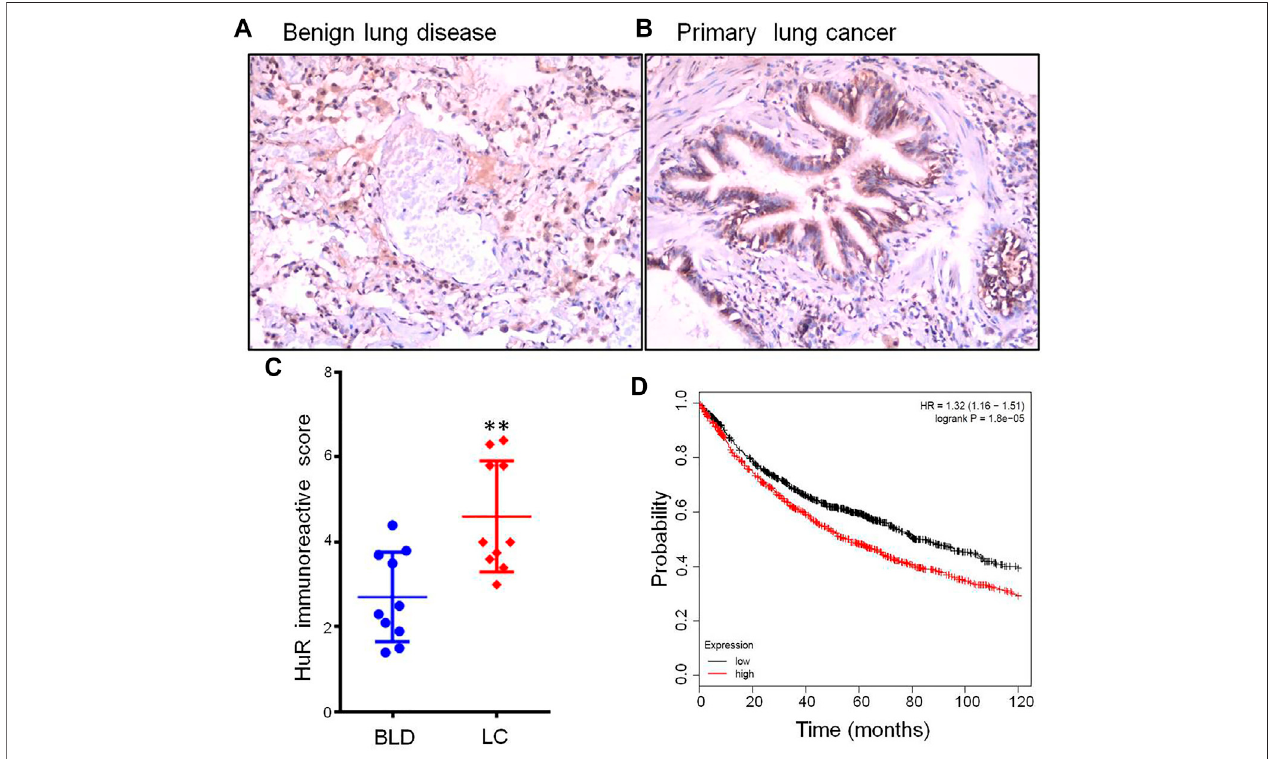
FIGURE1| HuRexpressioninlungcancerpatientsandbenignlungdiseasepatientswasdetectedusingimmunohistochemistry.HuRwasstainedinsamplesfrom patientswith (A) benign lung disease (200 × magni fi cation) and (B) lung cancer(200 × magni fi cation) by IHC. (C) The IRSofHuR in benign lung disease and lung cancer samples. (D) Kaplan-MeiercurveofoverallsurvivalaccordingtoHuRexpressionintheTCGA.Therewere962lungcancerpatientswithhighexpressionamongatotalof 1926 patients, and lung cancer patients with high expression of HuR had a poor prognosis ( p = 1.8e-05). ** p < 0.01. BLD, benign lung disease; LC, lung